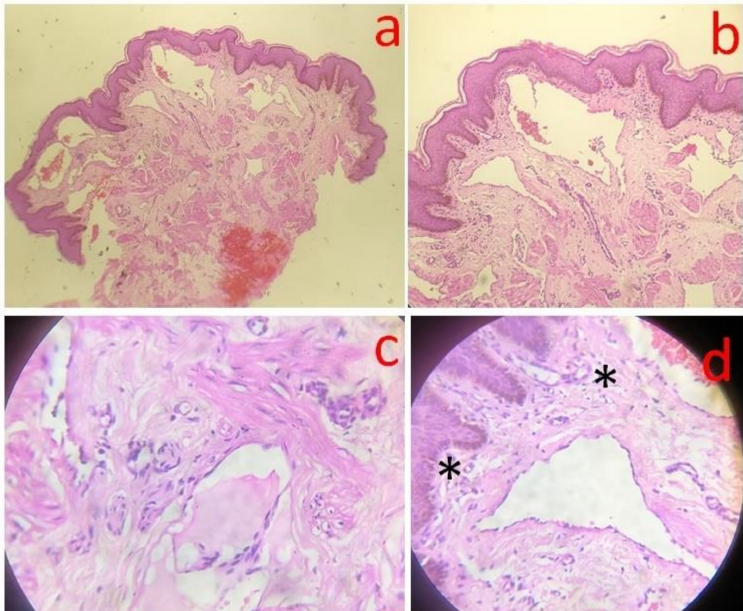
Figure 4. Photomicrograph depicting dilated lymphatic channels in the upper dermis. A valve inside the lymphatic channel is prominent. Acanthosis and superficial perivascular inflammatory infiltrate is also noted (H&E—20 × ). ( a ) Photomicro- graph (H&E stain; 4 × ), dilated upper dermal lymphatics are prominent. ( b ) At 10 × power (H&E stain), mild acanthosis is also noted along with ectatic lymphatic vessels in the papillary dermis. ( c ) Under 40 × objective (H&E stain), a valve is clearly noted in the lumen of the dilated lymphatic channel. Dartos muscle is prominent around the latter. ( d ) Under 40 × objective (H&E stain), papillary dermal mononuclear infiltrate is discerned along with capillaries (*) and dilated lymphatics.